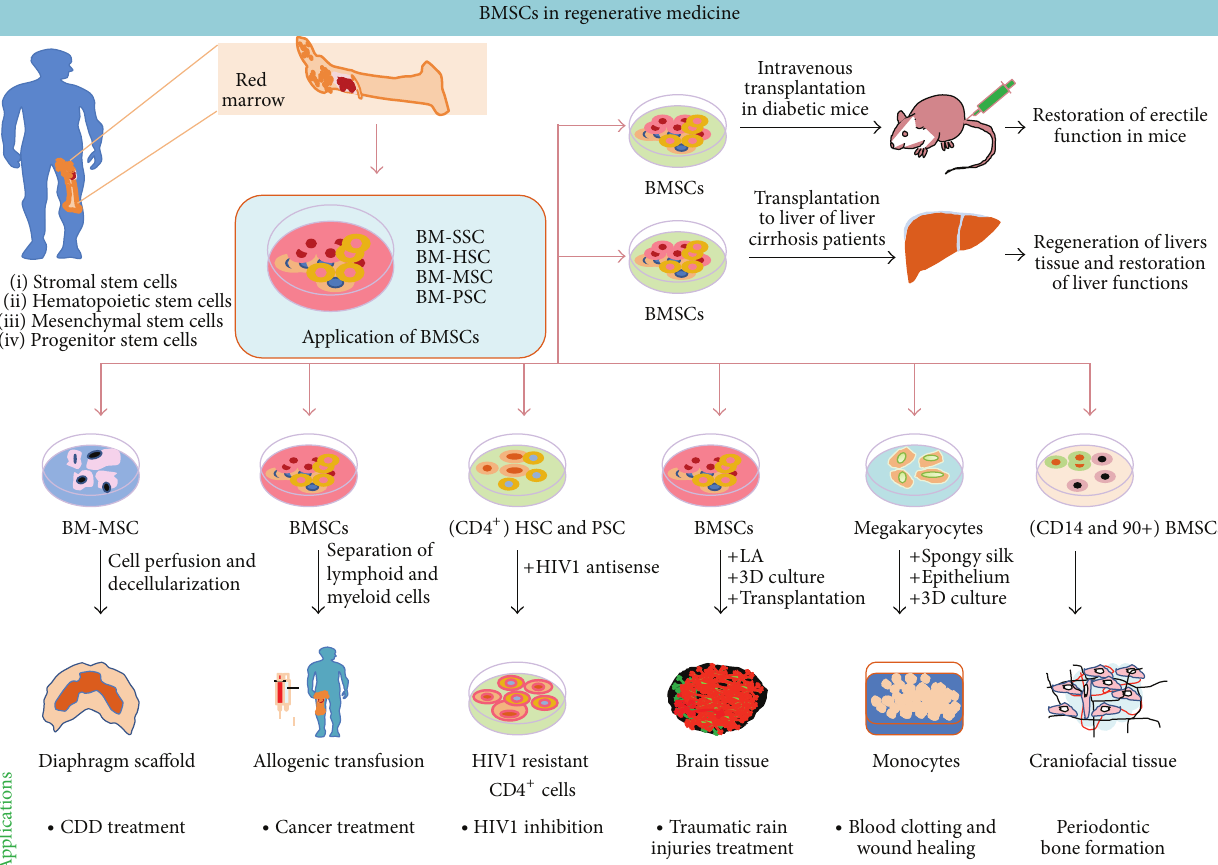
Figure 6: BMSCs in regenerative medicine: bone marrow, the soft sponge bone tissue that consisted of stromal, hematopoietic, and mesenchymal and progenitor stem cells, is responsible for blood formation. Even halo-HLA matched BMSCs can cure from disease and regenerate tissue. BMSCs can regenerate craniofacial tissue, brain tissue, diaphragm tissue, and liver tissue and restore erectile function and transdifferentiation monocytes. These multipotent stem cells can cure host from cancer and infection of HIV and